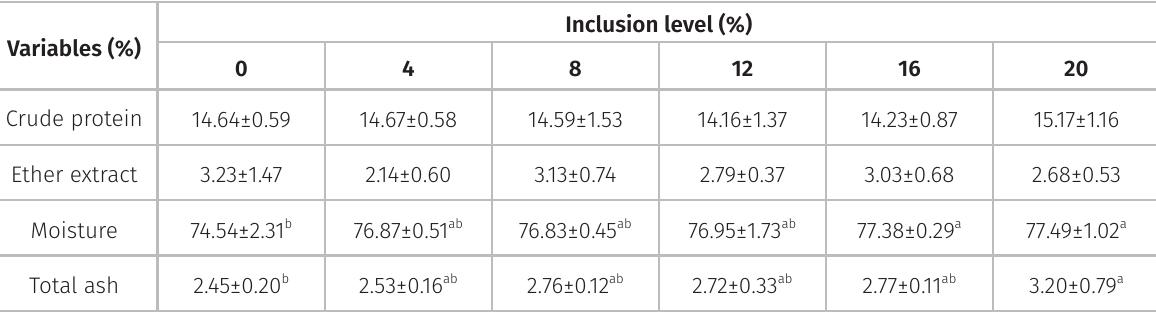
Table IV. Whole-body composition of Nile tilapia (Oreochromis niloticus) fingerlings fed diets containing different levels of crude glycerin